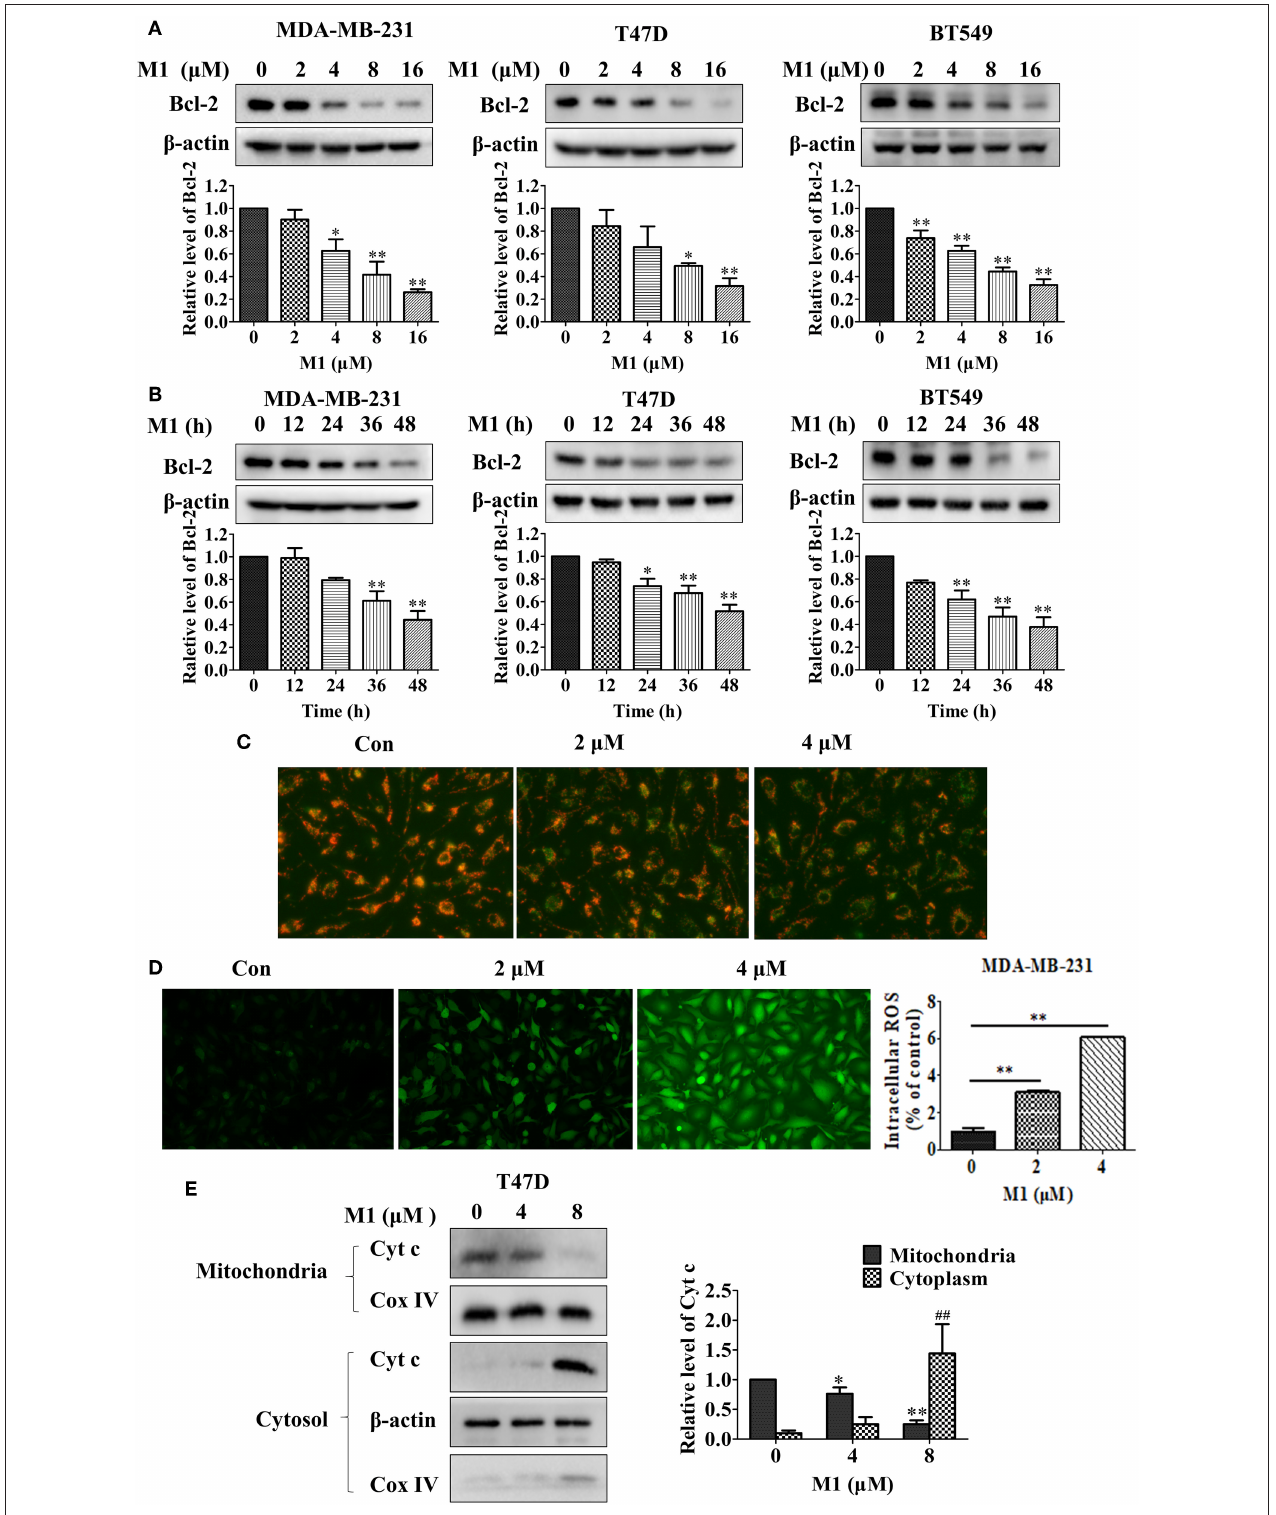
FIGURE 8 | Compound M1 downregulations Bcl-2 expression and induces mitochondrial dysfunction in breast cancer cells. MDA-MB-231, T47D, and BT549 cells were treated with different doses of compound M1 for 48h (A) , or were treated with 8 µ M M1 for difference time periods (B) , and the expressions of Bcl-2